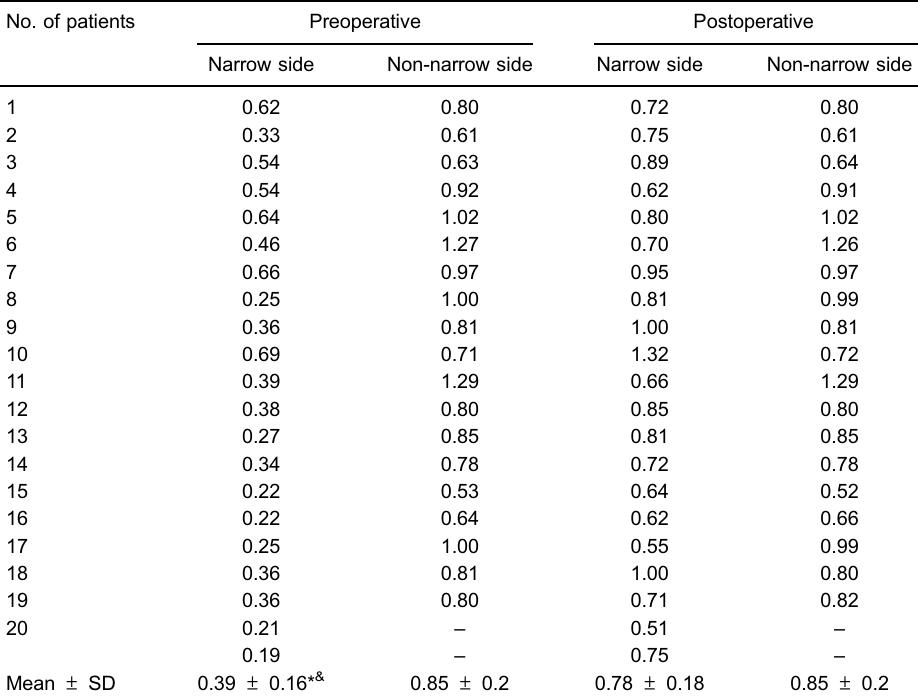
Table 1. Comparison of the cross-section area (in cm 2 ) of the nasal valve in 20 patients.